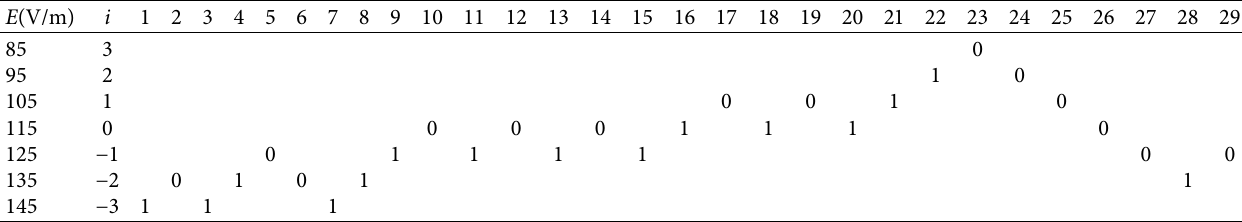
The test data were analyzed by the Bruceton method and combined with equations (8)–(12). E 0 � 115V/m, d � 10V/m, n � 14, A �− 1, B � 27, M � 1.9, and b � 0.1. The 50% ignition field strength of EED is calculated: E 50 � 115.0V/m. Standard deviation: σ � 39.8V/m.